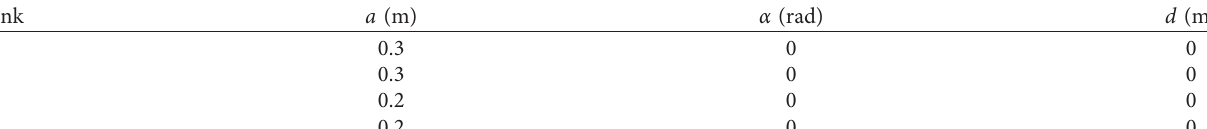
Table 4: The D-H parameter of the planer redundant manipulator with 4-DOFs.